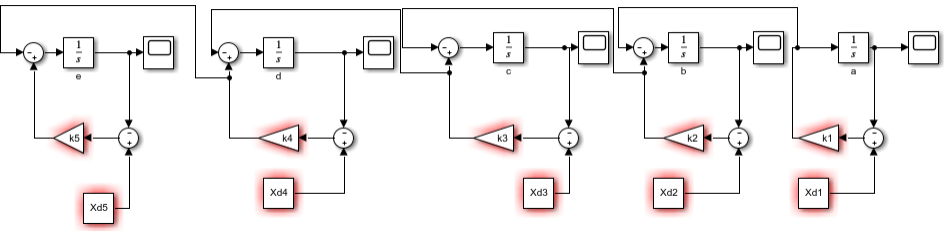
Figure 25. Block diagram for the confection process, with n = 5.